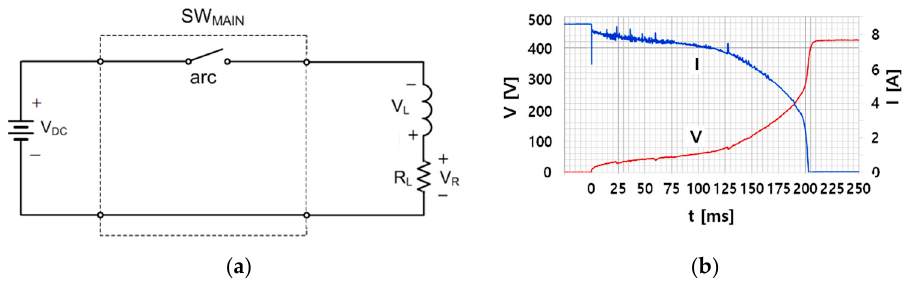
Figure 1. Power circuit and breaking arc of contact type switch; ( a ) Power circuit concept of contact type switch, ( b ) Breaking arc voltage/current waveform with resistive load.